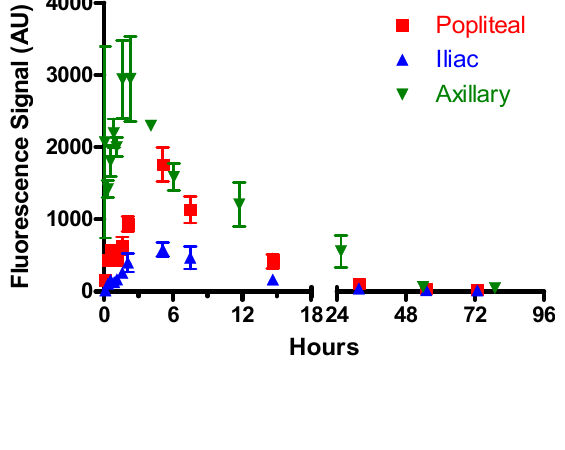
Figure 4. Lymphatic drainage kinetics of the free dye (5-carboxypentyl-amino-IR820) to the popliteal, iliac, and axillary lymph nodes after s.c. injection into the footpad or forearm. shallow nodes such as the axillary produce stronger signal intensities resulting in arbitrarily larger fluorescence signals. Relative fluorescence signals cannot be compared between nodes ( i.e. , axillary, popliteal, and iliac), due to different depths, to correlate relative amounts of the dye present between different